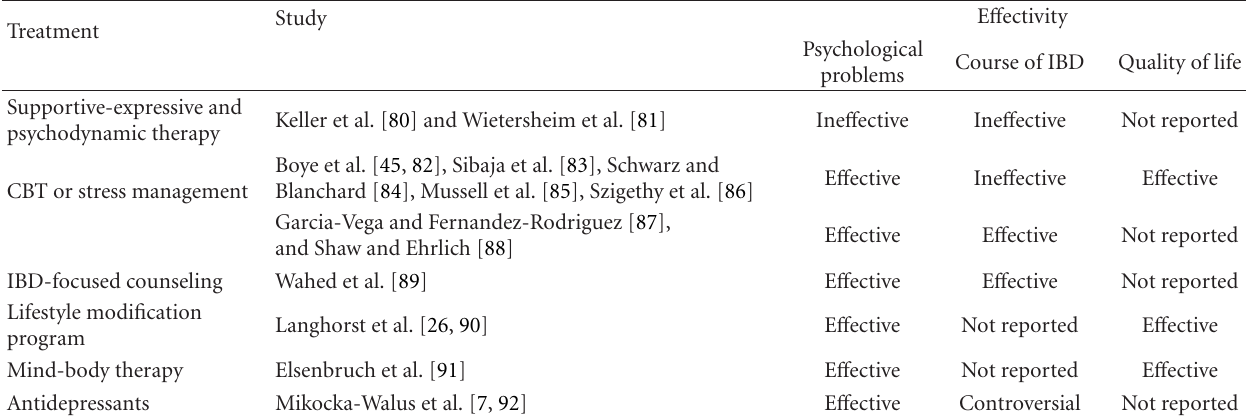
Table 2: Options for management of psychological disorders in patients with